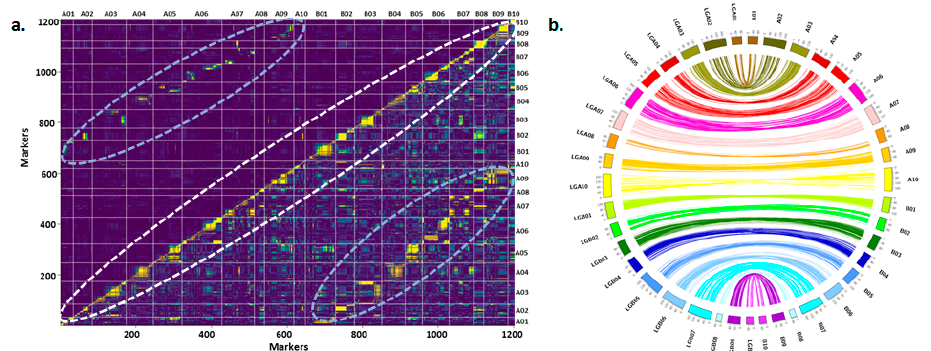
Figure 2. Pair-wise recombination fractions and recombination blocks across 20 chromosomes of Arachis hypogaea . ( a ) Recombination frequency plot representing the central unique set of markers segregating on each chromosome. On either side, the markers are showing the similar recombination frequency between homologous chromosomes of Arachis ipaensis and Arachis duranensis . ( b ) Circos plot representing the collinearity of genetic map between reference genomes of both sub-genomes. Table 3. Summary of main-effect and epistatic quantitative trait loci (QTLs) for drought tolerance-and iron deficiency tolerance-related traits.